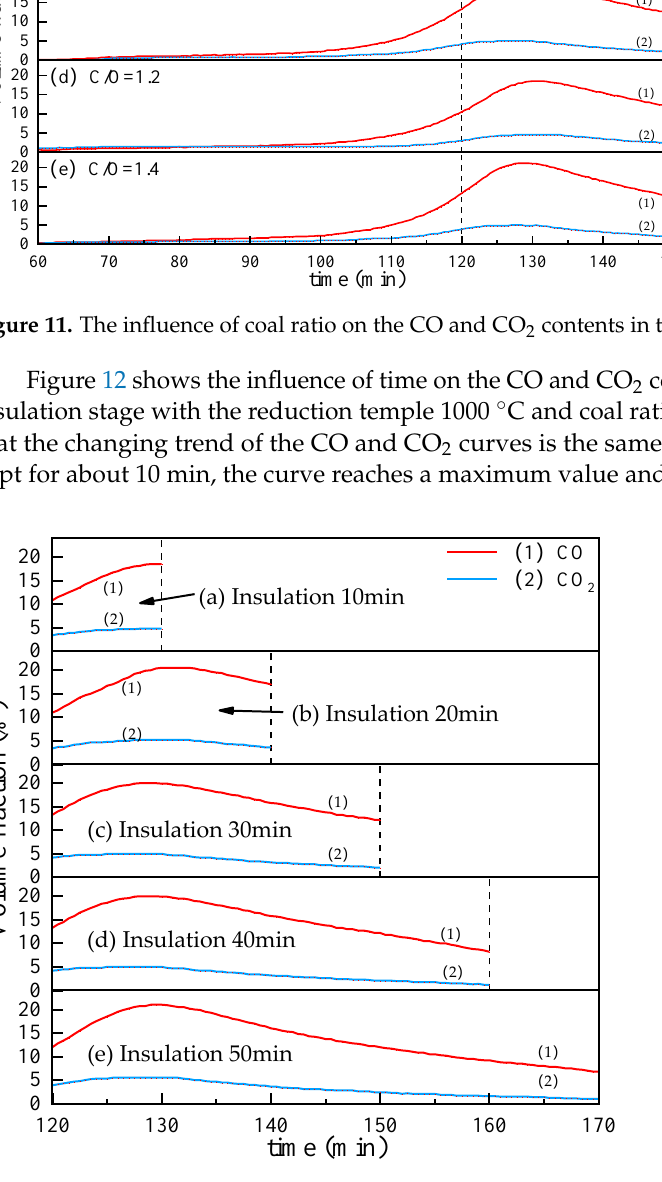
CO 2 /CO values required for the free FeO, Fe 2 TiO 4 , and FeTiO 3 phases during the reduction of VTM by CO were calculated, as shown in Table 7. When the actual value of CO 2 /CO is greater than the corresponding required theoretical equilibrium value, the substance may